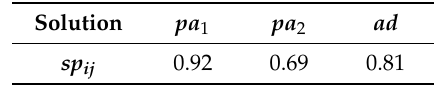
Table 8. Illustrative example of Solution combining with pa and ad .